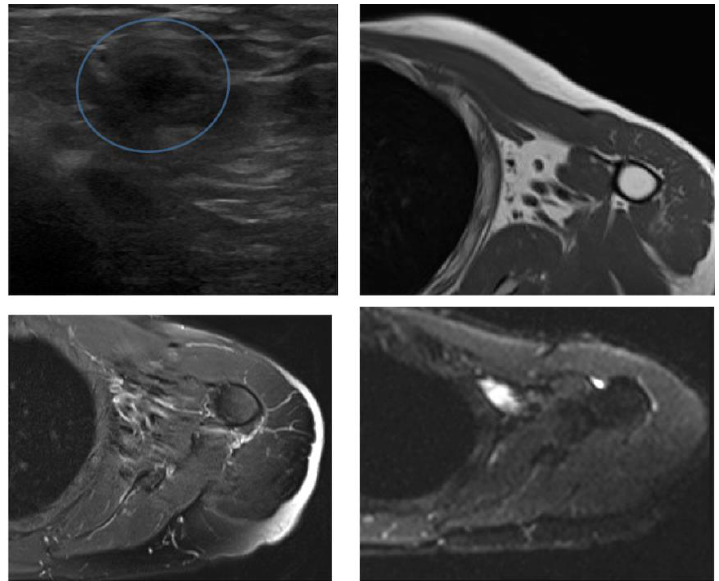
Figure 5. A 71-year-old man with intermediate-grade leiomyosarcoma of the proximal arm. US was reported as positive for recurrence due to the detection of a pseudomass/irregularity of the superficial tissues of the proximal arm (circle). MRI did not show any mass. Follow-up did not show any recurrence.